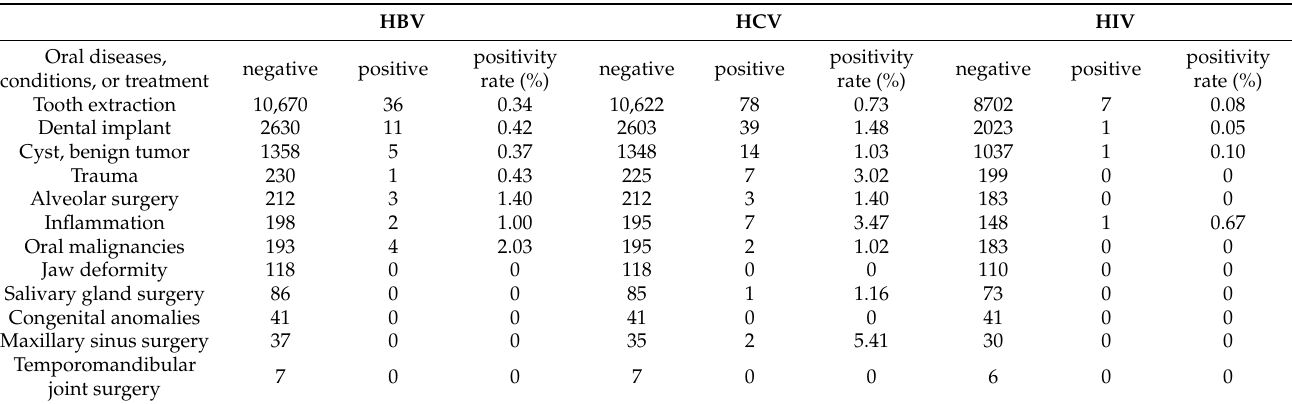
Table 6. Prevalence of infectious diseases, According to various oral diseases.